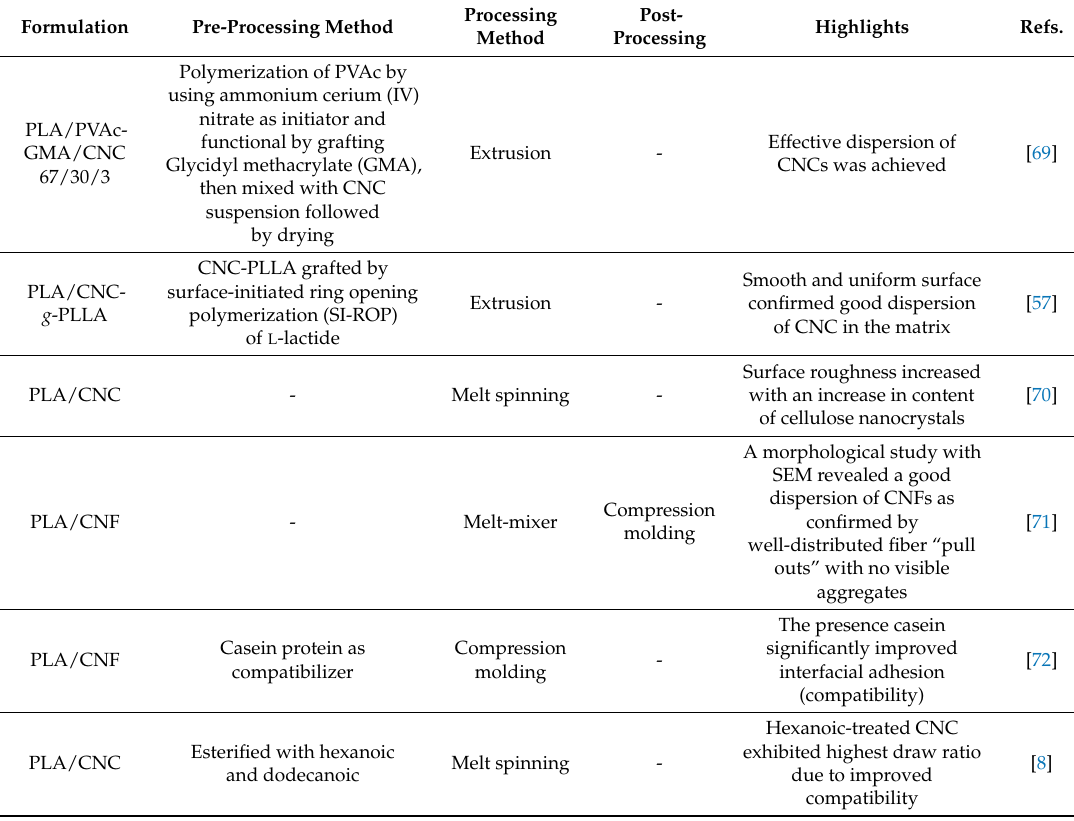
Table 4. Selected studies, based on thermoplastic processing techniques of PLA/ cellulose nanocomposites.